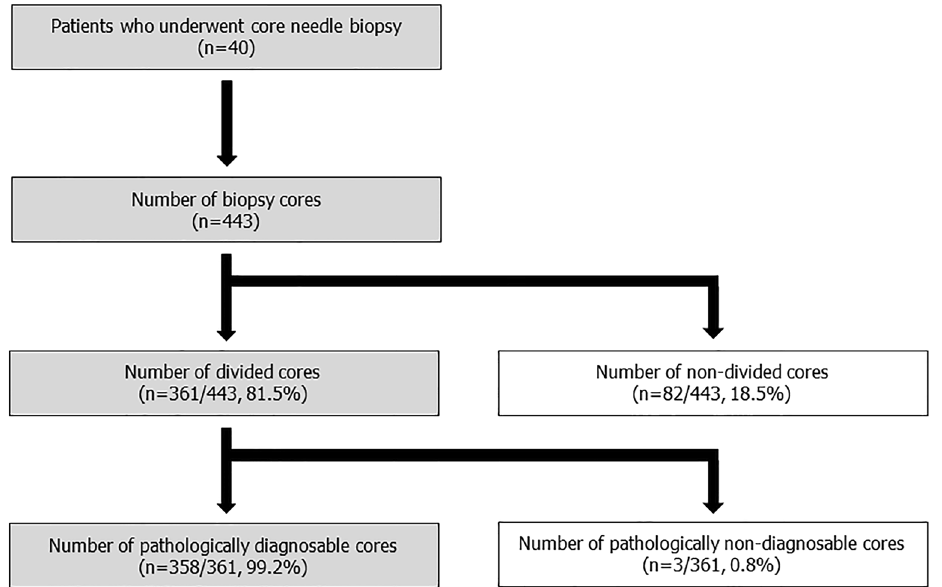
Figure 1. Patient and sample selection. Of a total of 443 biopsy cores from 40 patients, 361 biopsy cores (81.5%) were divided into two pieces using the new device. Of these, histopathological diagnosis was successfully made in 358 biopsy cores